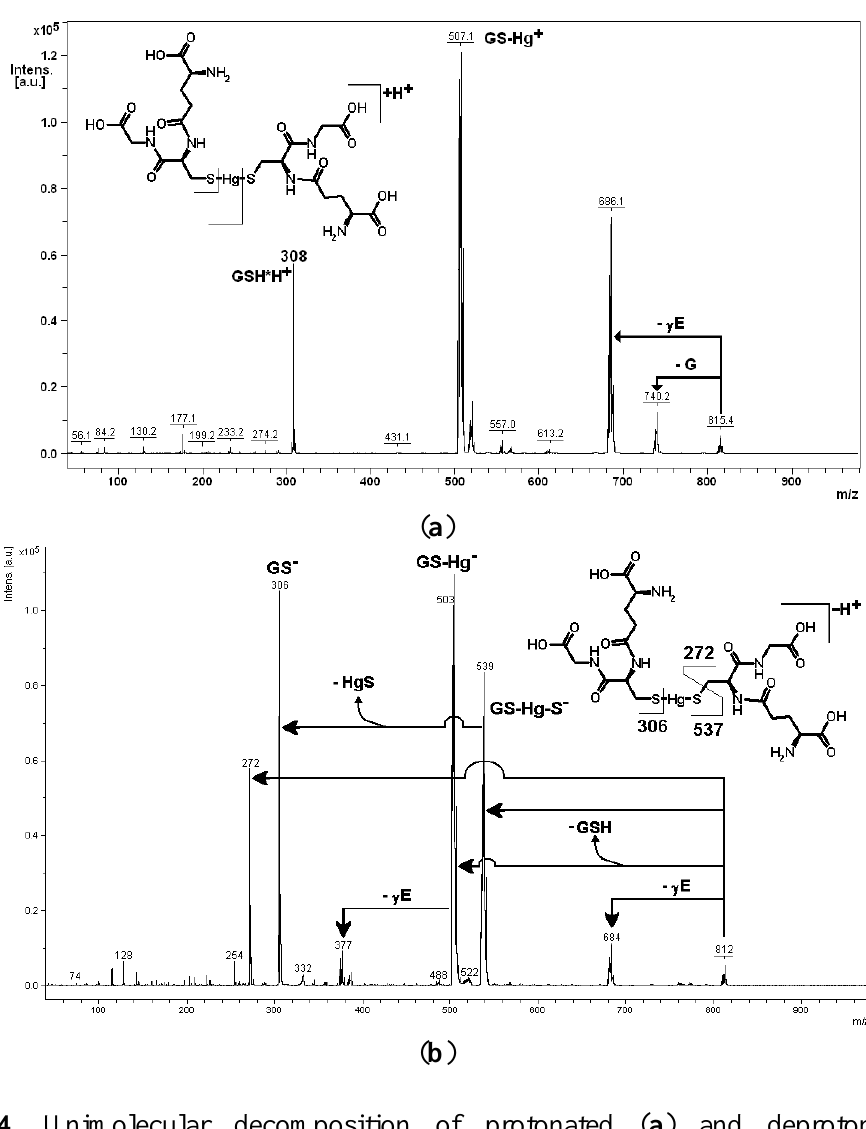
Figure 4. Unimolecular decomposition of protonated ( a ) and deprotonated ( b ) bis- gluthathionato-mercury(II) obtained in a MALDI-ToF-ToF instrument (sinapinic acid matrix; 15 kV collision energy).